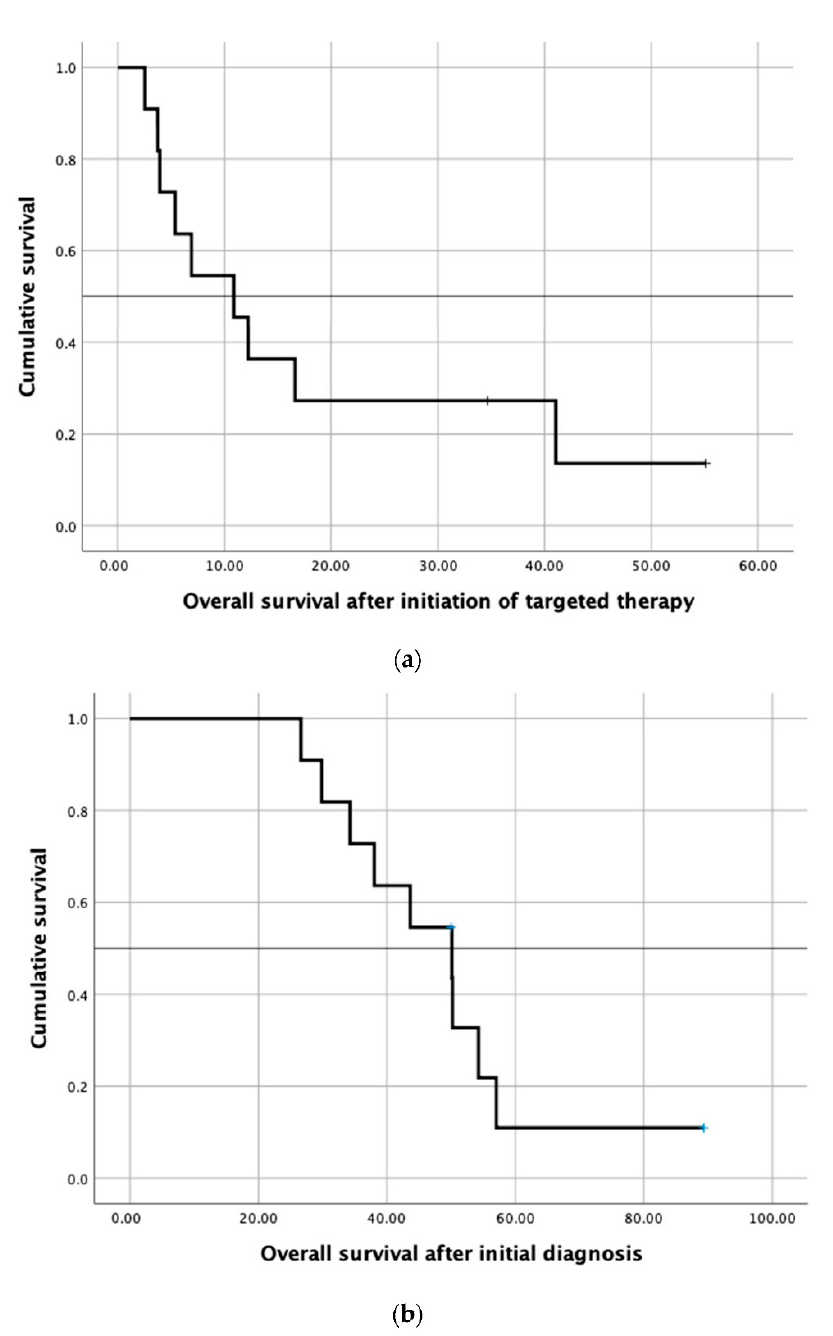
Figure 4. ( a ) Kaplan–Meier survival curve showing overall survival after initiation of targeted therapy in twelve patients receiving the targeted therapy and ( b ) Kaplan–Meier survival curve showing overall survival after initial diagnosis of mCRC in twelve patients receiving the targeted